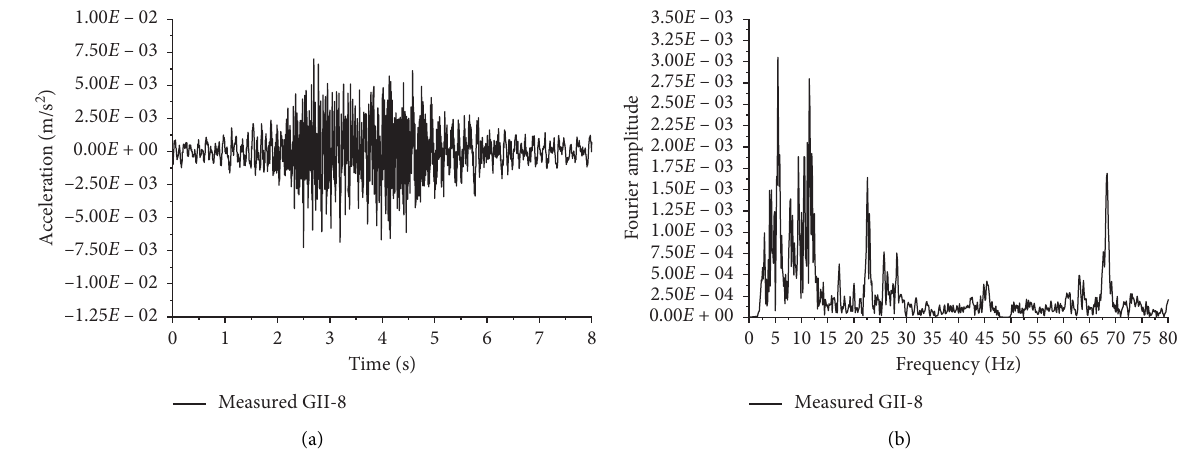
Figure 7: Acceleration: (a) time history and (b) frequency spectrum of GII-8.